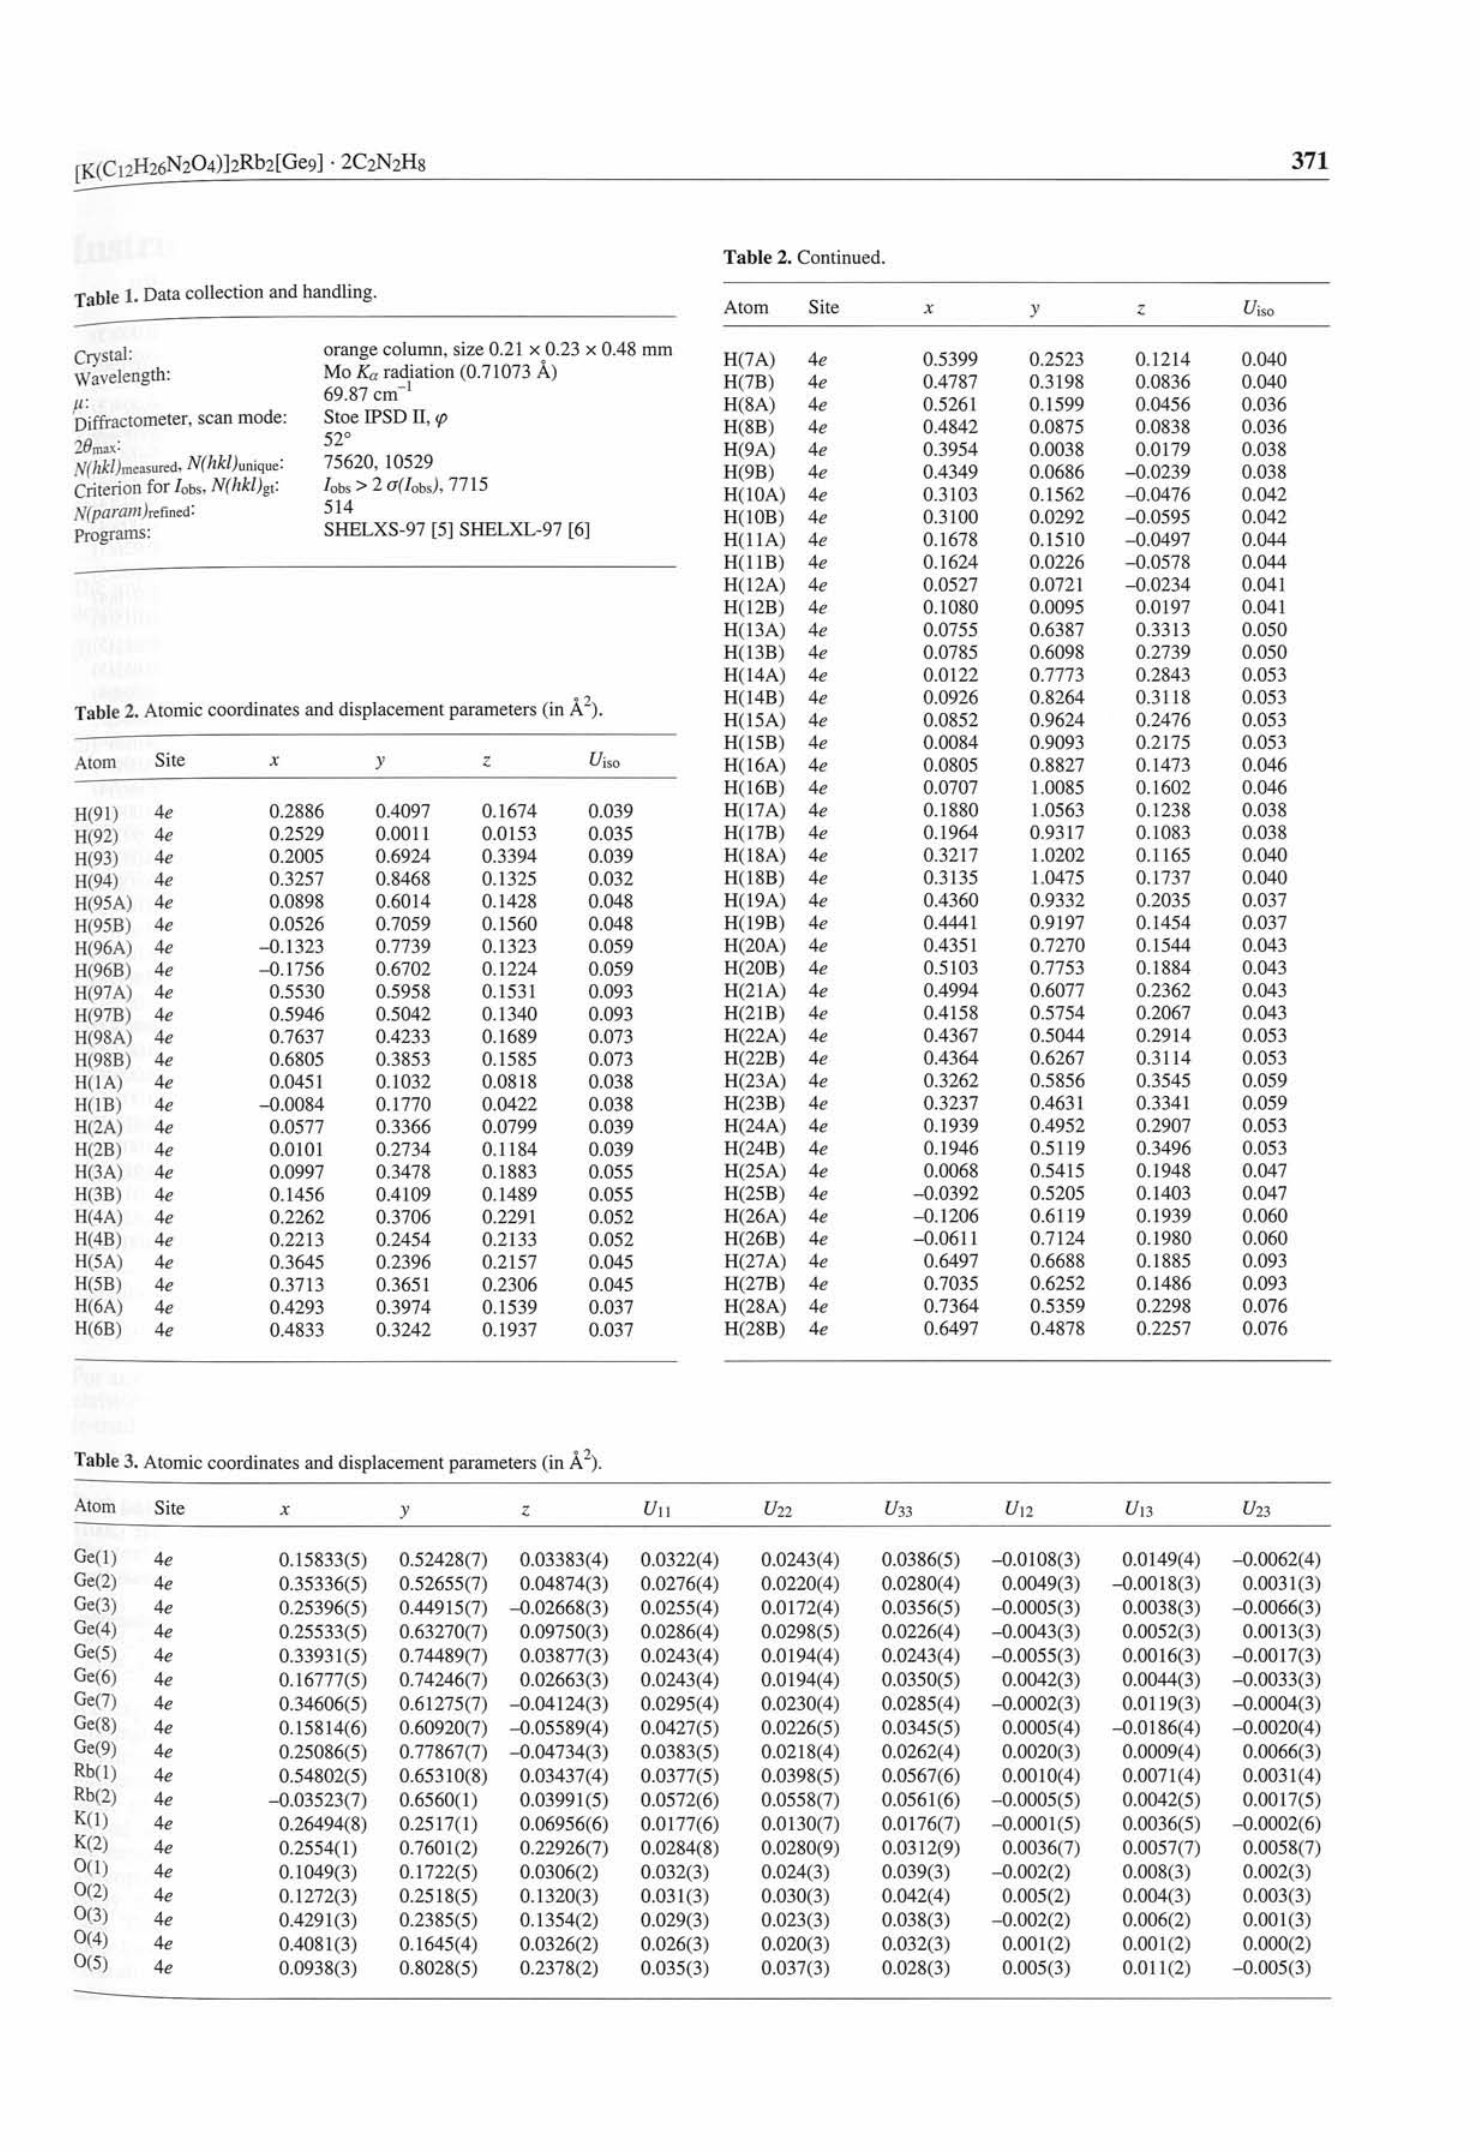
Table 3. Atomic coordinates and displacement parameters (in Â 2